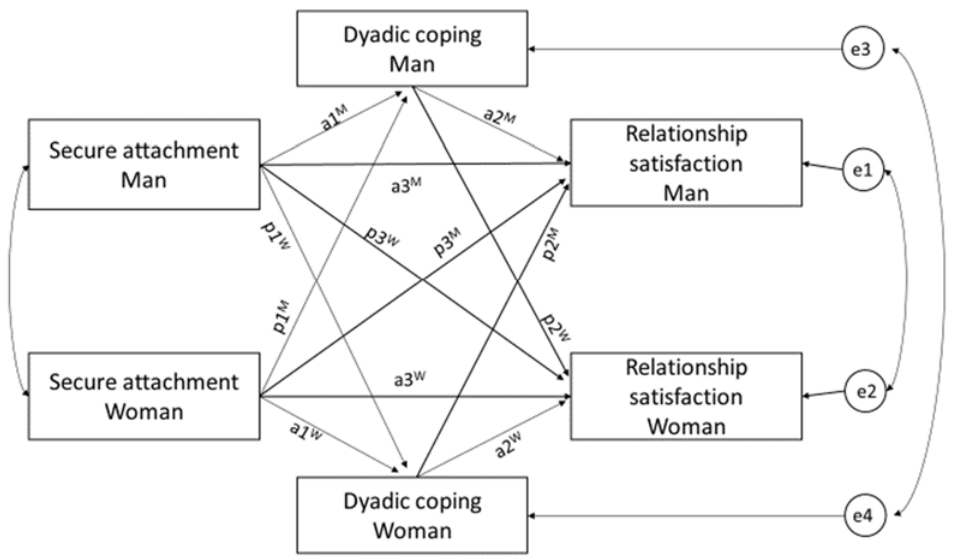
Figure 1. Actor–partner interdependence mediation model. Rectangles = predictor and outcome variables; circles = error terms (e1–4); curved double-headed arrows = covariances; a = actor effect; p = partner effect; W = women; M = men. Models were computed separately for five dyadic coping (DC) scales (self-perceived supportive DC and other-perceived supportive DC, self-perceived delegated DC, other-perceived delegated DC, and common DC) as mediators.